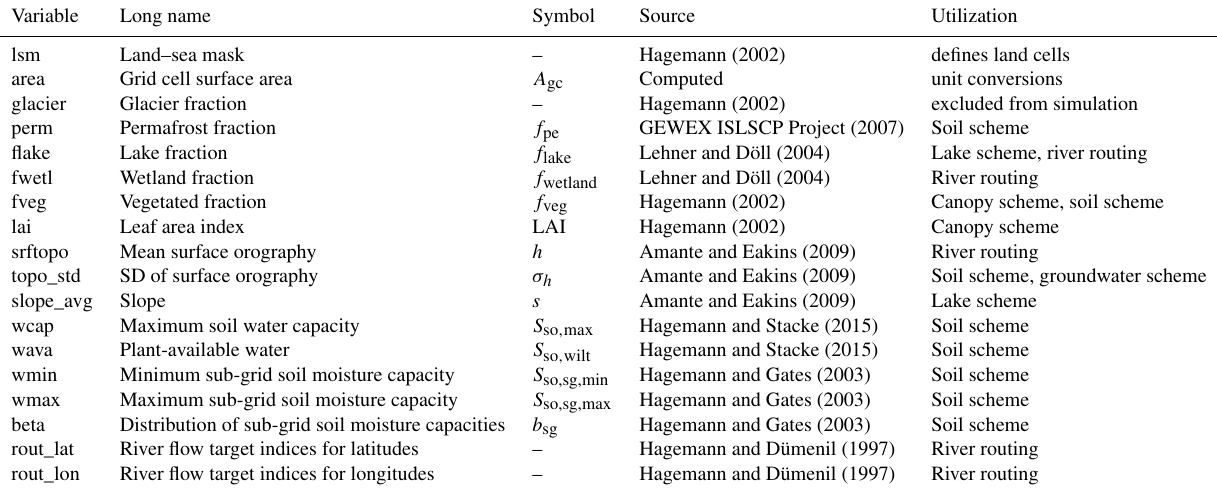
Table 2. Land surface data variables and their use (directly or as input for derived variables) in the default setup of HydroPy. A symbol is provided for all variables that are used in equations in the hydrological process (Sect. 2.2) or input data description (Sect. 3). Variable